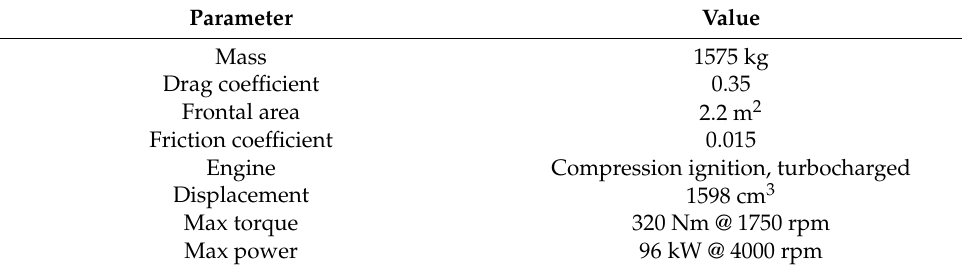
Figure 1. Nissan X-Trail used for this study installed in the vehicle test bench. Table 1. Vehicle specifications.